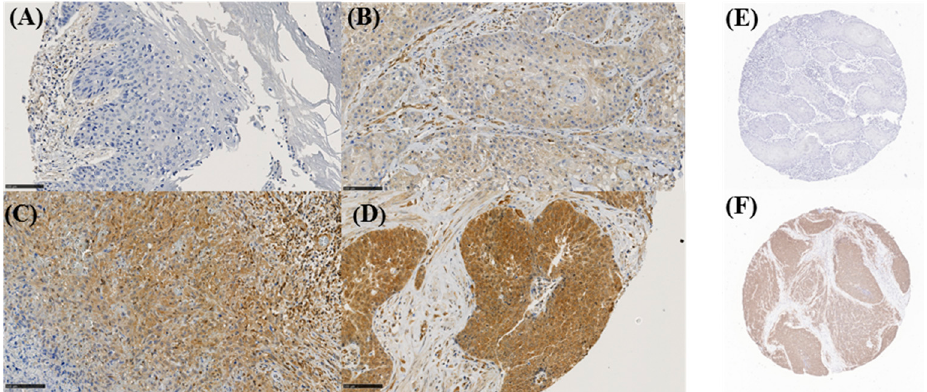
Figure 1. Immunohistochemical PeCa tissue sections stained with AKT antibody representing intensity score grades in 0 ( A ), 1 ( B ), 2 ( C ) and 3 ( D ), scale bar = 100 µm. p16INK4a staining was graded in negative ( E ) and positive ( F ).